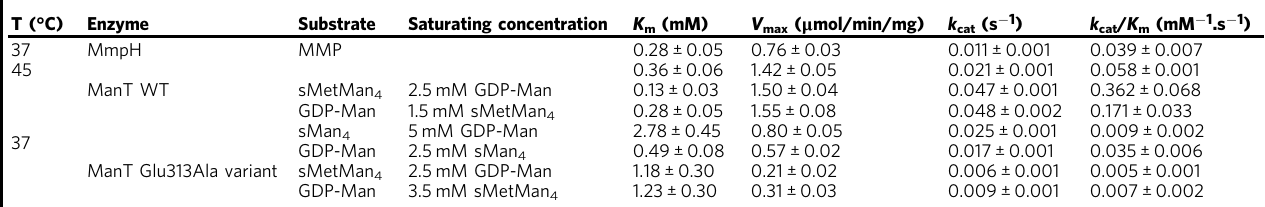
Table 1 Kinetic properties of MmpH, ManT and ManT Glu313Ala variant. T (°C)